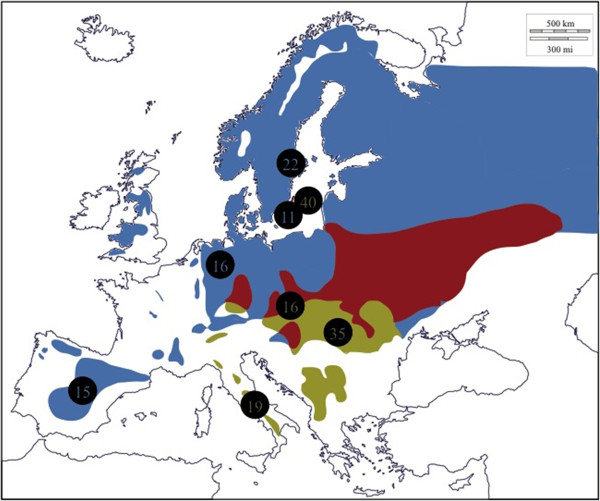
European breeding distribution ranges for the pied flycatcher (Ficedula hypoleuca, light blue), the collared flycatcher (Ficedula albicollis, green), and regions where both species occur together (red). Unreservedly redrawn and adapted from range maps in Cramp & Perrins [27]. Circles indicate sampling sites and the number of birds collected on each site is given within the circle. Numbers for pied flycatchers are in blue font and numbers for collared flycatchers are in green font.